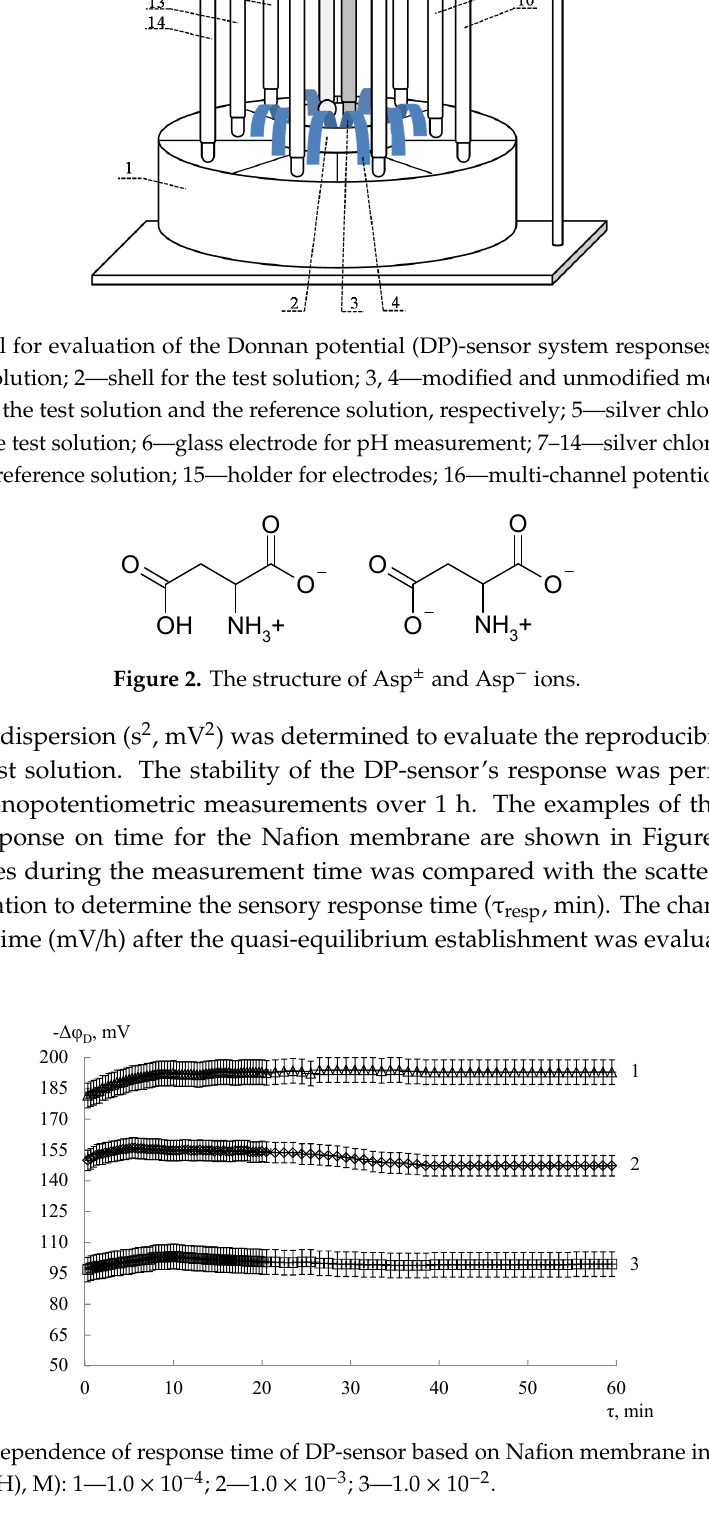
Figure 3. The dependence of response time of DP-sensor based on Nafion membrane in test solutions ( c (Asp) = c (KOH), M): 1—1.0 × 10 − 4 ; 2—1.0 × 10 − 3 ; 3—1.0 × 10 − 2 . The system of calibration equations for a selected DP-sensors system (the number of equations is equal to the number of analytes) was solved to calculate the analyte concentrations in the model solutions and pharmaceutical. The experimental data for calculating concentrations were the response values of DP-sensors and pH values in the analysis object. The relative error ( δ = ( c exp − c theor )/ c theor , %) and the relative standard deviation ( s r = s / c exp , %) were calculated to evaluate the accuracy and the reproducibility of analytes determination. Panangin ® contains 45.2 mg/mL of potassium asparaginate hemihydrate, 40.0 mg/mL of magnesium asparaginate pentahydrate (active substances), and water for injection. The content of